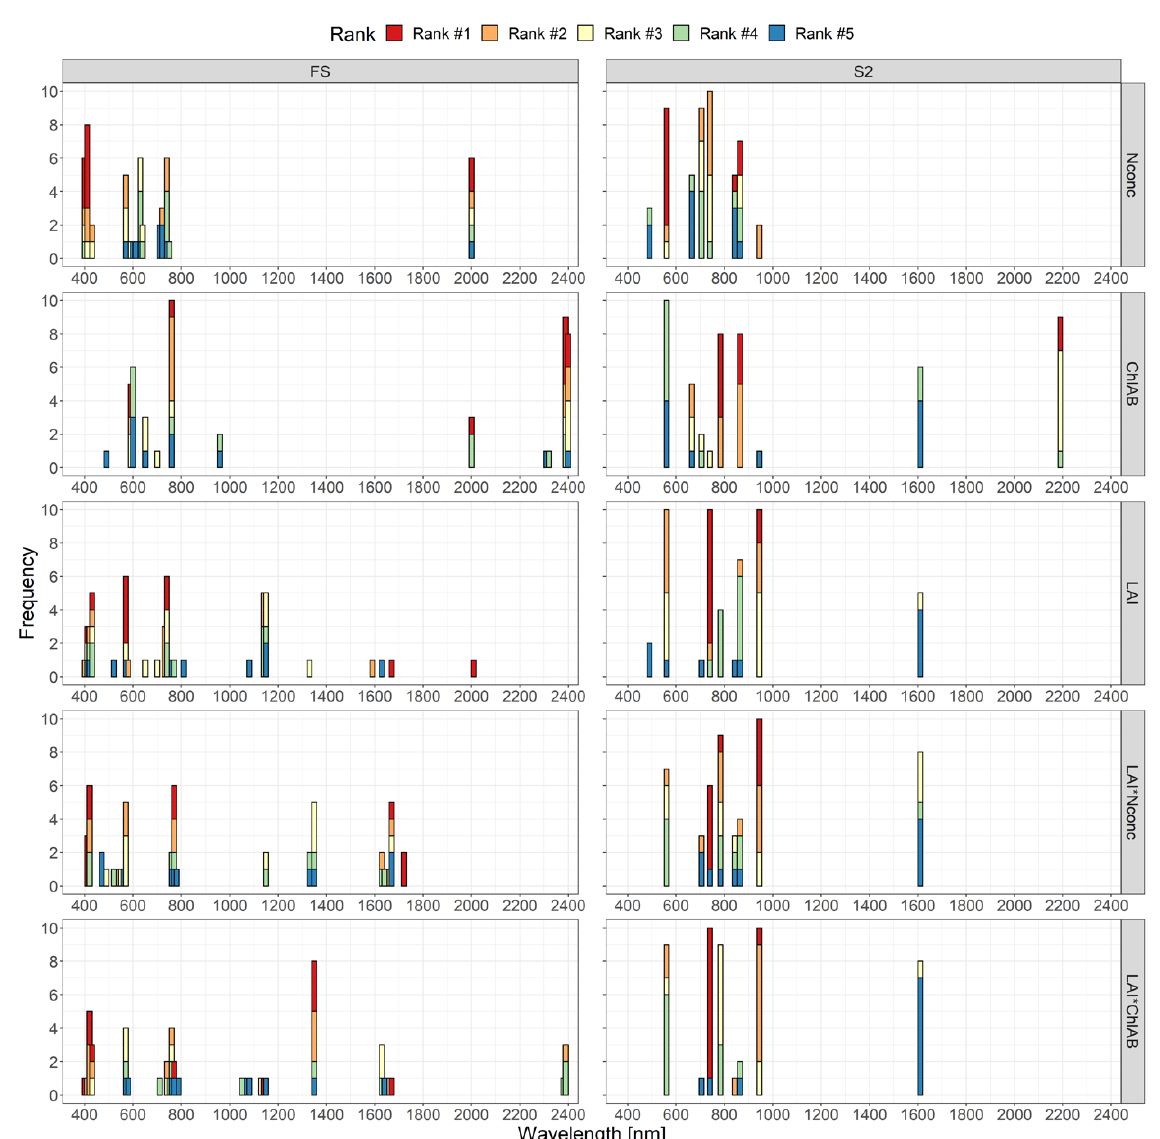
Figure 4. Occurrence of the top five ranked bands with lowest GPR sigma values for the ASD sensor ( left ) and the S2 resampled sensor ( right ). Data from 10-fold cross validation, e.g., 50 (10 folds × 5 ranks) is the maximum possible occurrence.